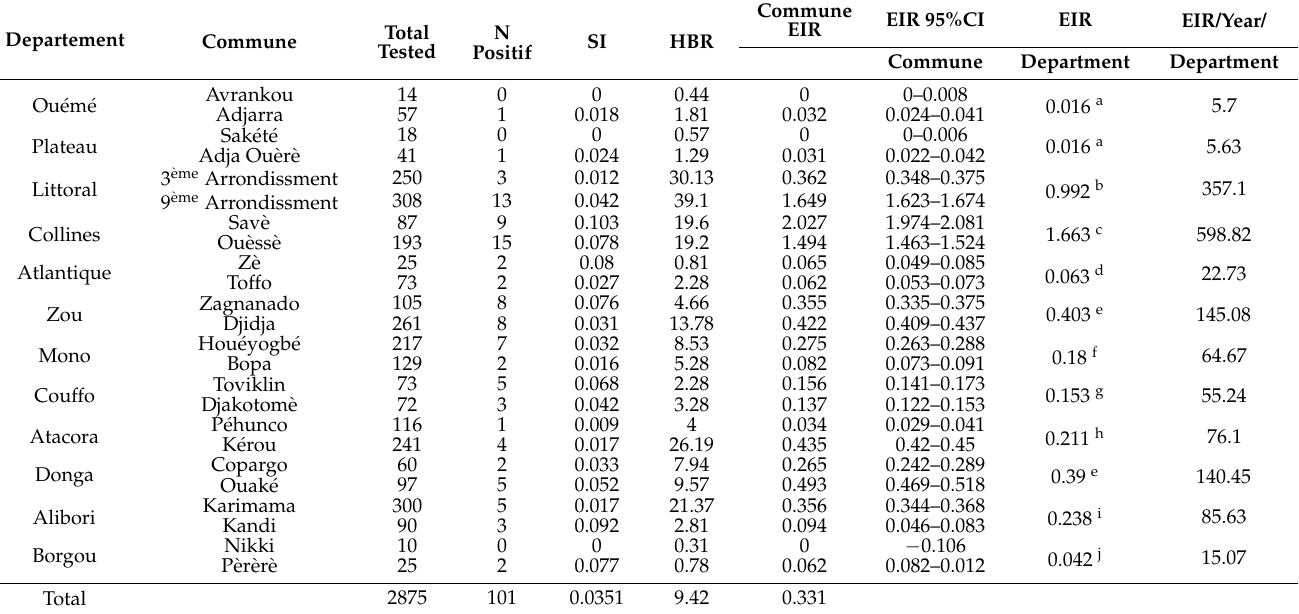
Table 3. Sporozoite Index and EIR by commune and